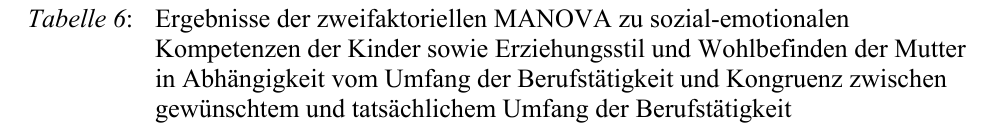
Tabelle 6 : Ergebnisse der zweifaktoriellen MANOVA zu